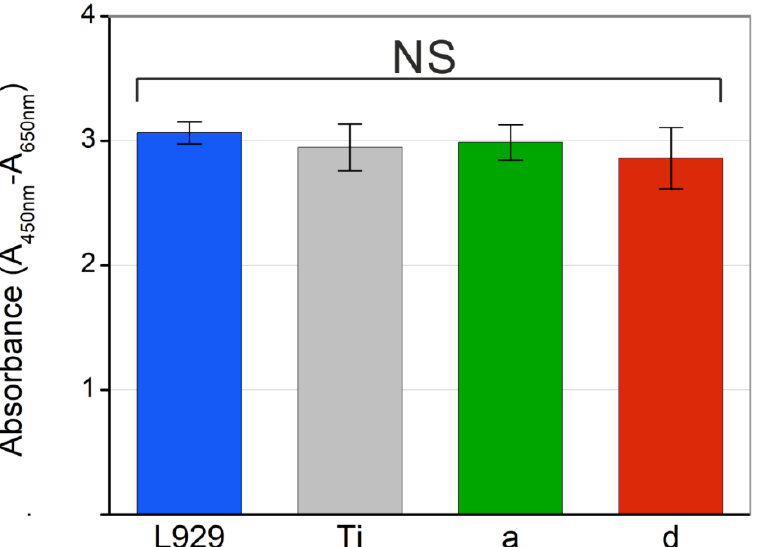
Figure 12. Viability of L929 fibroblast cells expressed in terms of normalized absorbance. ( L929 ) control culture of fibroblasts; ( Ti ) culture of fibroblasts on titanium discs without nanoparticles; ( a , d ) culture of fibroblasts on titanium discs with immobilized Pd nanoparticles synthesized by laser ablation ( a ) in water with 532 nm of wavelength and ( d ) in methanol with 1064 nm.